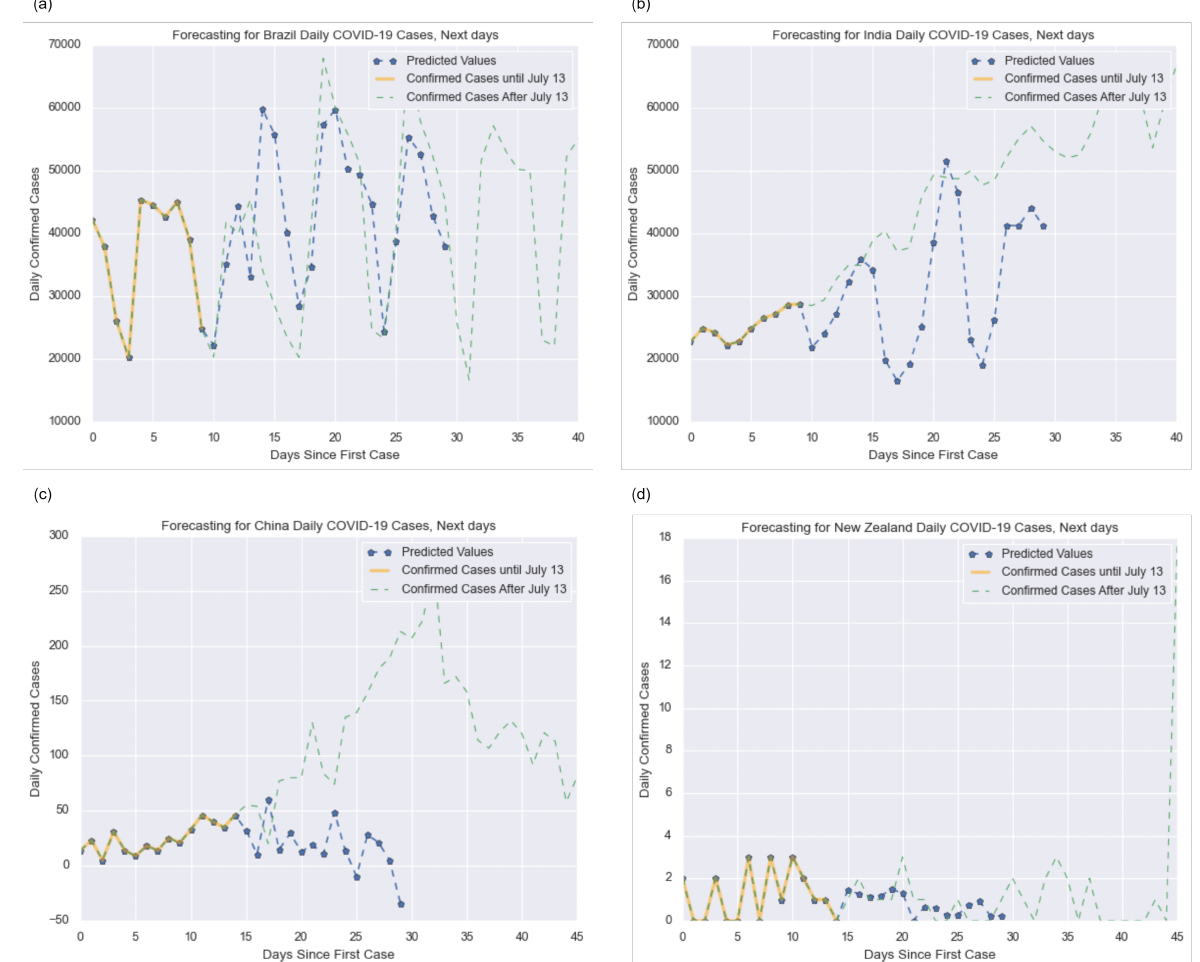
Figure 17. Forecasting Results for the Best LSTM Models. In (a) we show the forecasting results of the best LSTM model for Brazil daily COVID-19 cases. We show in (b) the forecasting results of the best LSTM model for India daily COVID-19 cases. For countries that have controlled the COVID-19 evolution, in (c) we show the forecasting China, and in (d) we show the results for New Zealand in both countries, the predictions show a progressive growth in the number of